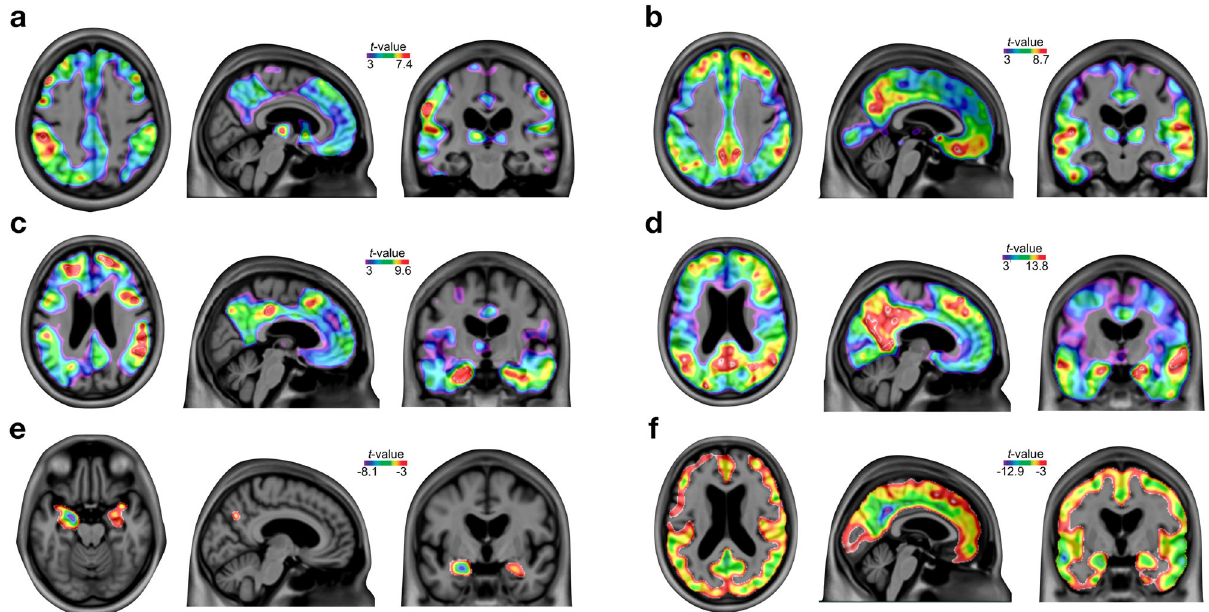
Fig. 3 Regional diagnostic effects on amyloid- β , tau, and gray matter density. T -statistical parametric maps of two-sided t -tests false discovery rate corrected for multiple comparison at P < 0.05 show increased amyloid- β PET in a MCI ( n = 14) and b patients with AD ( n = 15); tau PET in c MCI ( n = 14) and d patients with AD ( n = 15); and decreased gray matter density in e MCI ( n = 15) and f patients with AD ( n = 16) as compared to CU elderly, in individuals at the MCSA